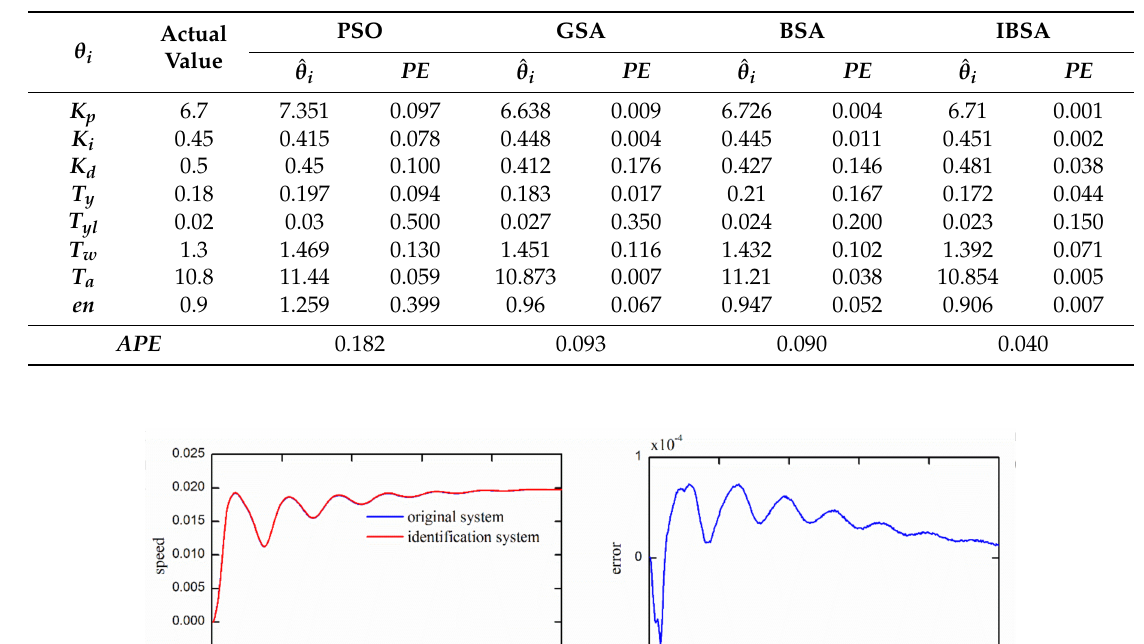
Table 2. Parameter identification error of the four algorithms under load disturbance.